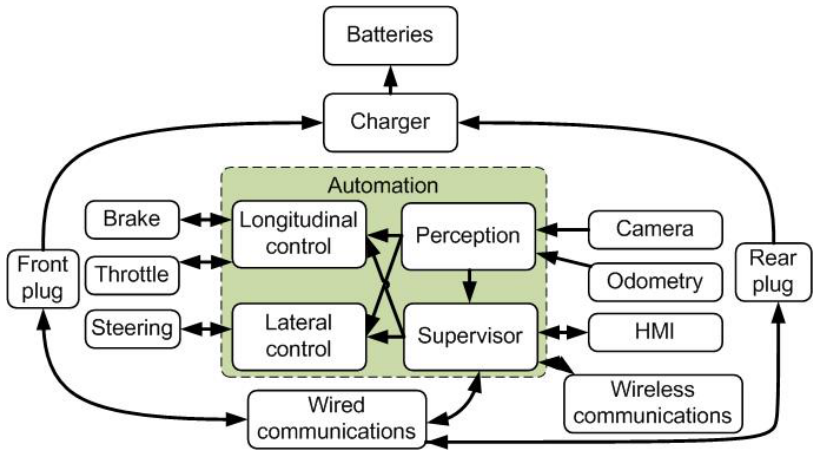
Figure 2. Automated vehicle on the AMARE